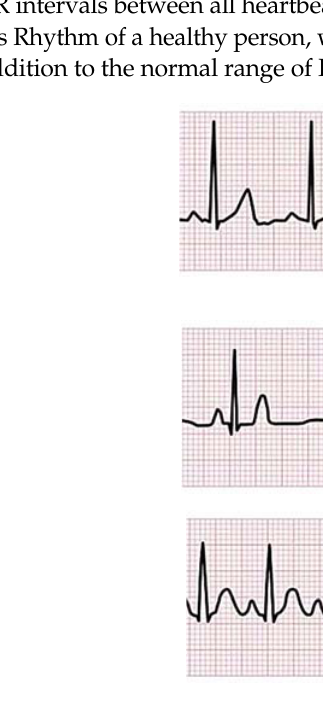
Figure 3. Normal Sinus Rhythm vs. Sick Sinus Syndrome examples: ( a ) Normal Sinus Rhythm example; ( b ) Bradycardia example that shows a slow sinus rhythm (big RR intervals); ( c ) Tachycardia example that shows a fast sinus rhythm (small RR intervals).